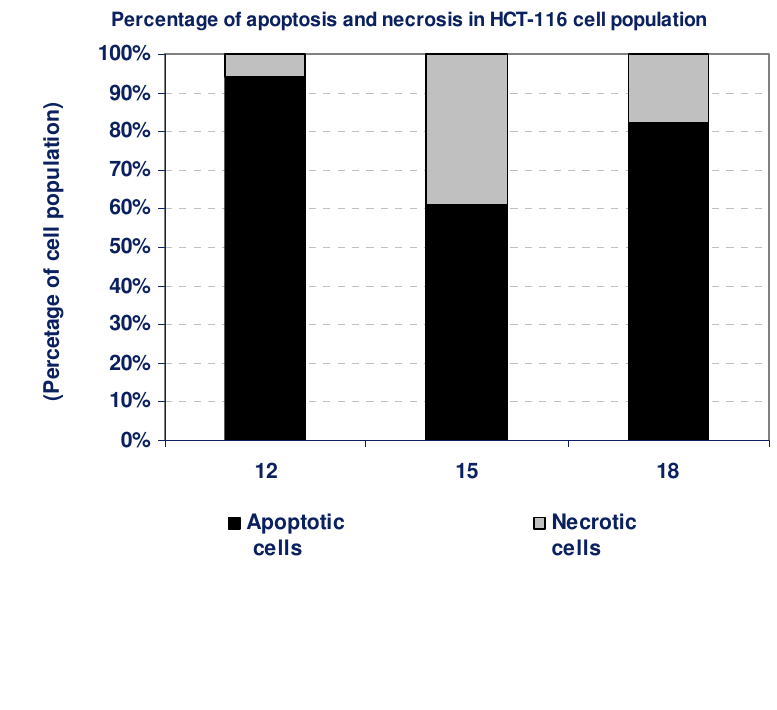
Figure 6. The type of cell death was investigated in HCT-116 cells after the treatment with the promising cytotoxic compounds, using acridine orange/ethidium bromide staining to compare between the percentage of necrotic cells (grey segment) and the apoptotic cells (black segment). Data are representing mean value ±